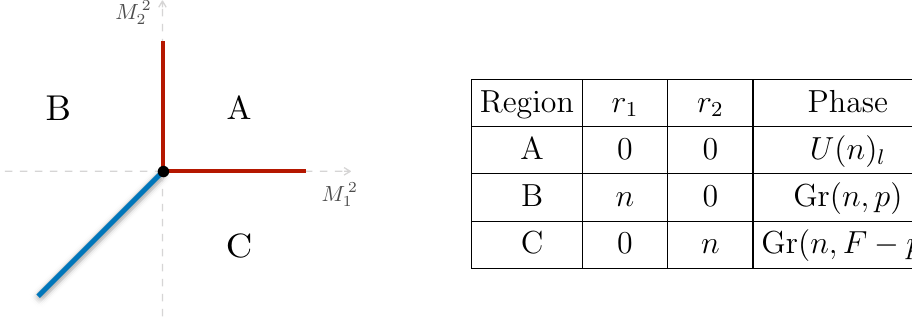
Figure 11 . Phase diagram of the bosonic theory in the case n < p region of double condensation shrinks to the blue line R